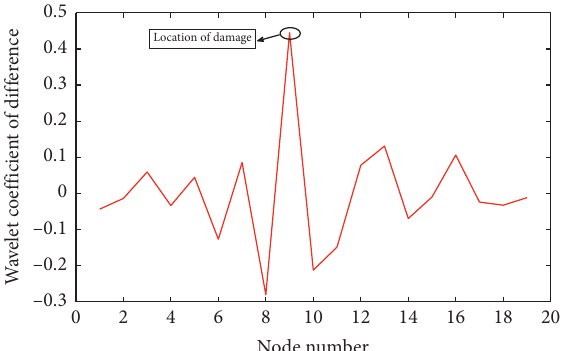
Figure 21: Wavelet coefficient difference for 20% damage in section 10.